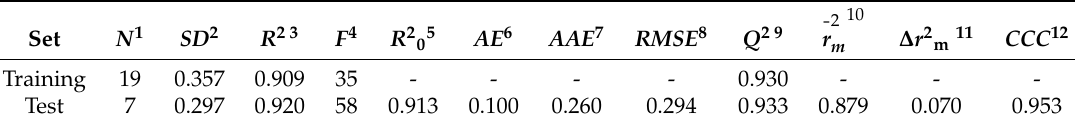
Table 3. Summary of statistical results for the best-found quantitative structure–activity relationships (QSAR)